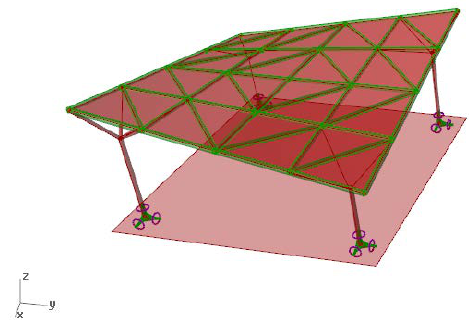
Figure 9. Perspective view of the optimal structure; the structure of pattern a, received due to surface division into four parts along its edges (structure a3, T7).